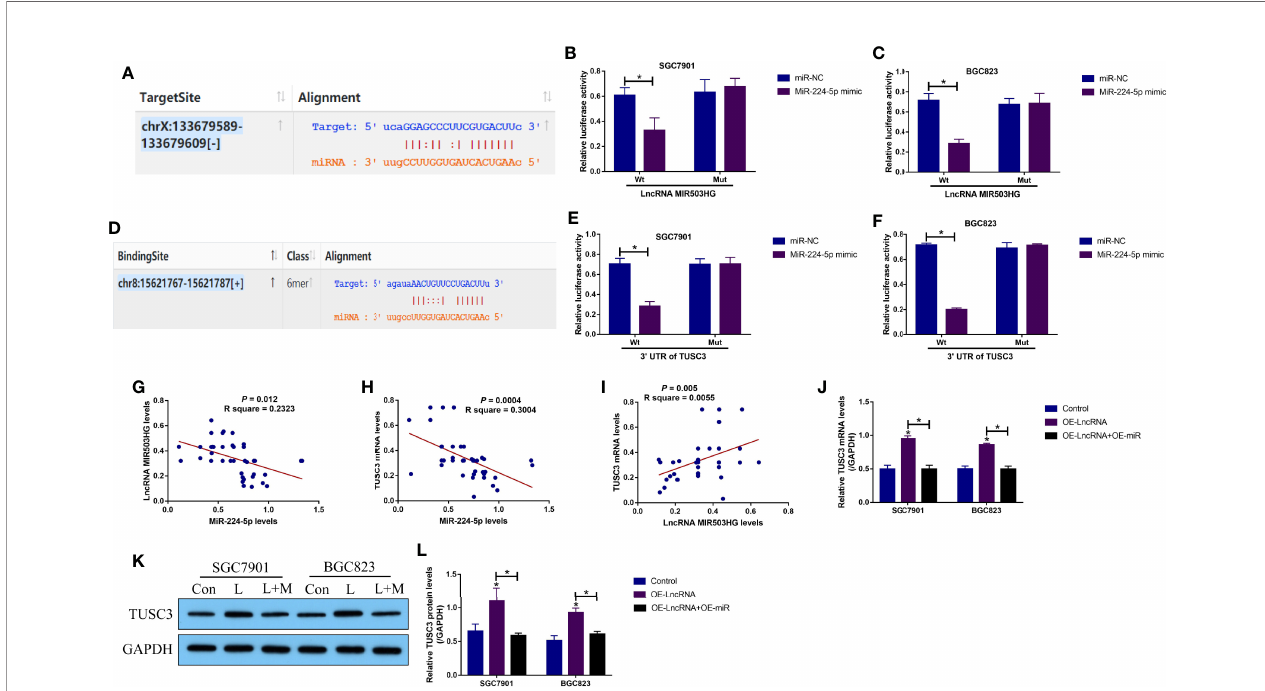
FIGURE 3 | The regulatory mechanisms of LncRNA MIR503HG, miR-224-5p and TUSC3 in GC cells. The targeting sites of miR-224-5p with (A – C) LncRNA MIR503HG and (D – F) 3 ’ UTR of TUSC3 mRNA were predicted by the online starBase software (http://starbase.sysu.edu.cn/) and were validated by the following dual-luciferase reporter gene system assay. The activities of the fi re fl y luciferase was normalized by the Renilla luciferase. (G – I) The correlations of LncRNA MIR503HG, miR-224-5p and TUSC3 in GC tissues were analyzed. (J) Real-Time qPCR and (K, L) Western Blot were performed to determine TUSC3 expressions in GC cells. “ L ” represented “ LncRNA MIR503HG overexpression ” , and “ L+M ” indicated “ OE- LncRNA MIR503HG+OE-miRNA ” . Each experiment contained 3 repetitions, and P < 0.05 were marked by “ * ”